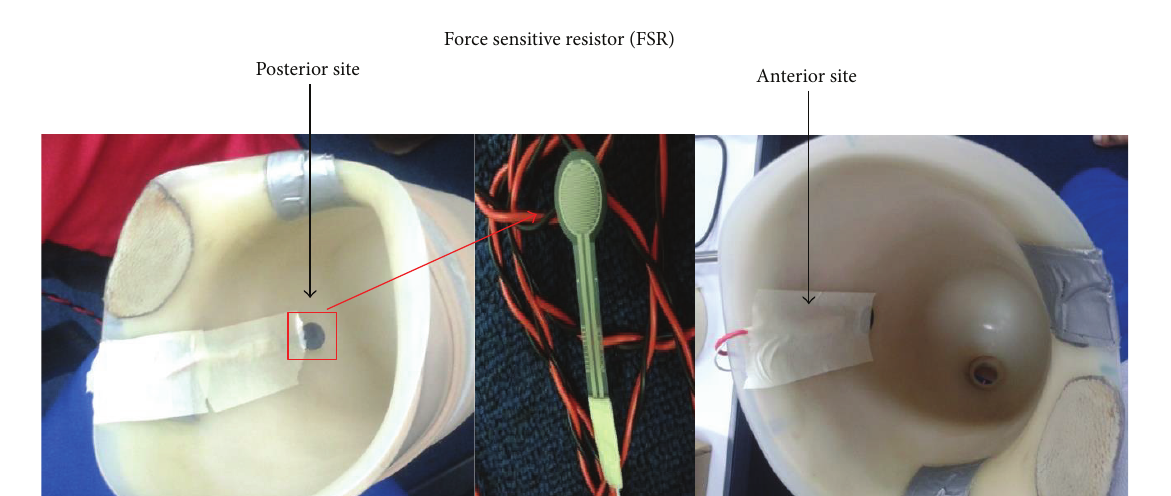
Figure 1: FSRs locations inside the socket during the experiment for both anterior and posterior sites.